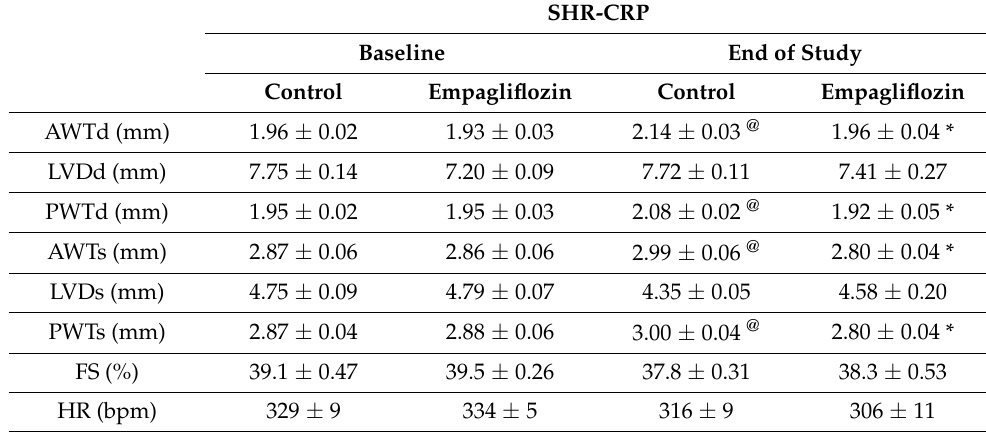
Table 2. Echocardiography parameters in adult animals at the end of the